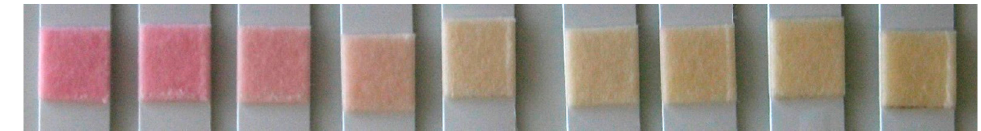
Figure 8. Example of calibration set for iodide determination (from left to right—blank, 0.05, 0.125, 0.25, 0.5, 1.25, 2.5, 5, 25 mM). Tl(III)–PAR complex ( c Tl ~ 0.5 mM, ratio 1 : 1).